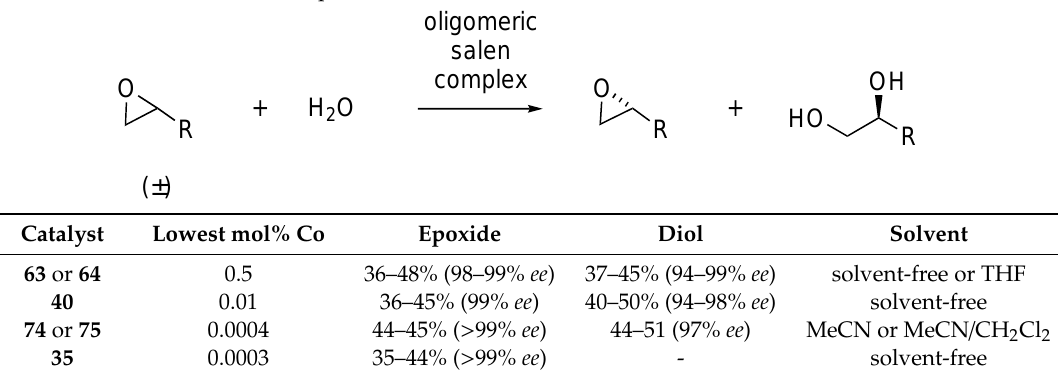
Table 1. Comparison of catalytic properties of oligosalen Co(III) complexes in the hydrolytic kinetic resolution (HKR) of terminal epoxides.